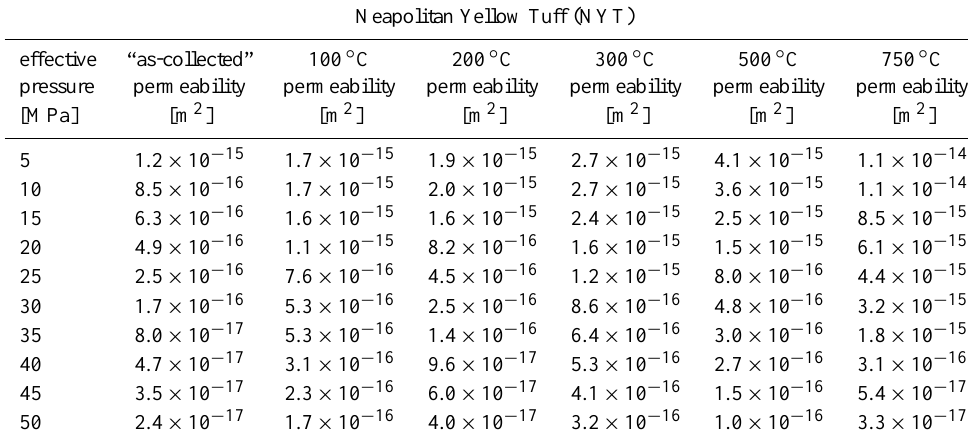
Table 5. Water permeability of WGI as a function of effective pressure and thermal stressing temperature. effective